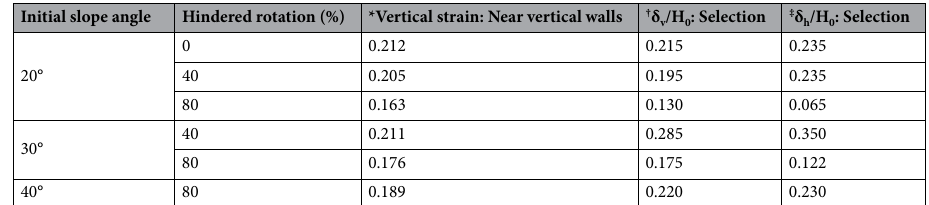
Table 2. Normalized displacements—DEM simulations. *: Heights of level-ground portion: β 0 = 20°: 60 mm, β 0 = 30°: 71.2 mm, β 0 = 40°: 82 mm. † : Vertical movements of grains at the top of the selection normalized by their initial heights. ‡ : Horizontal movements of grains at the top of the selection normalized by their initial